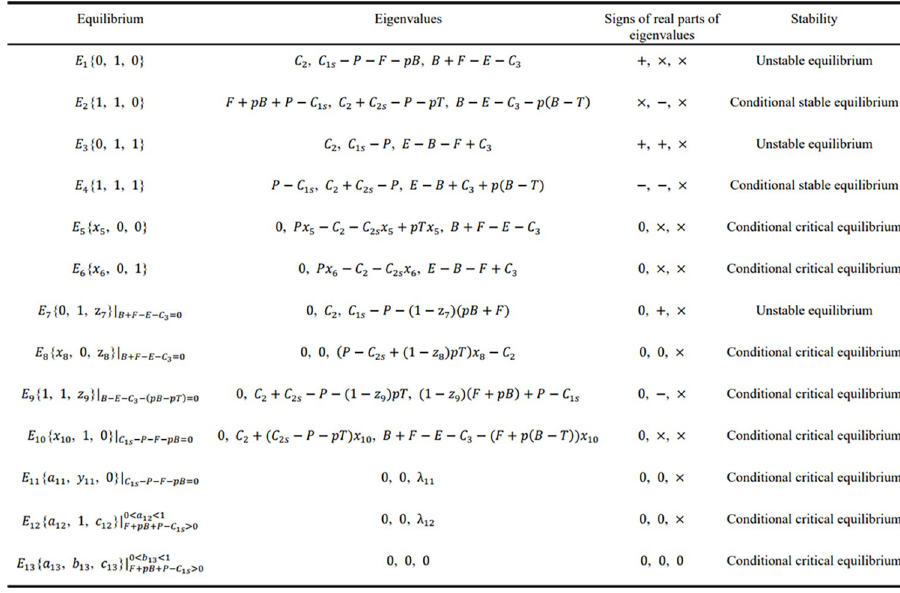
Fig 4. Stability analysis of